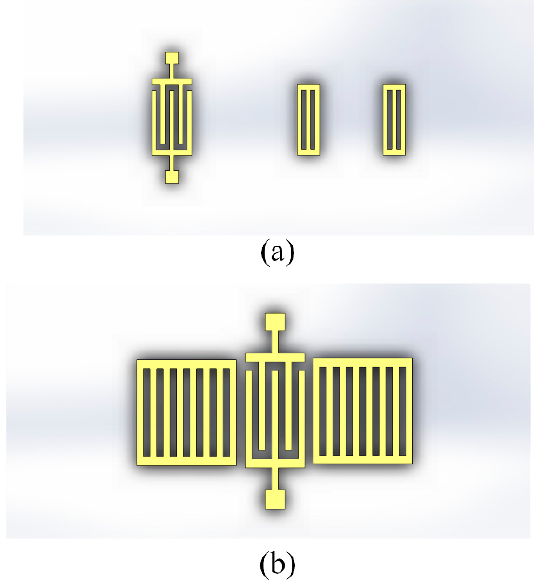
Figure 1. Schematic diagrams of ( a ) Reflective delay line and ( b ) Resonator surface acoustic wave (SAW) sensors